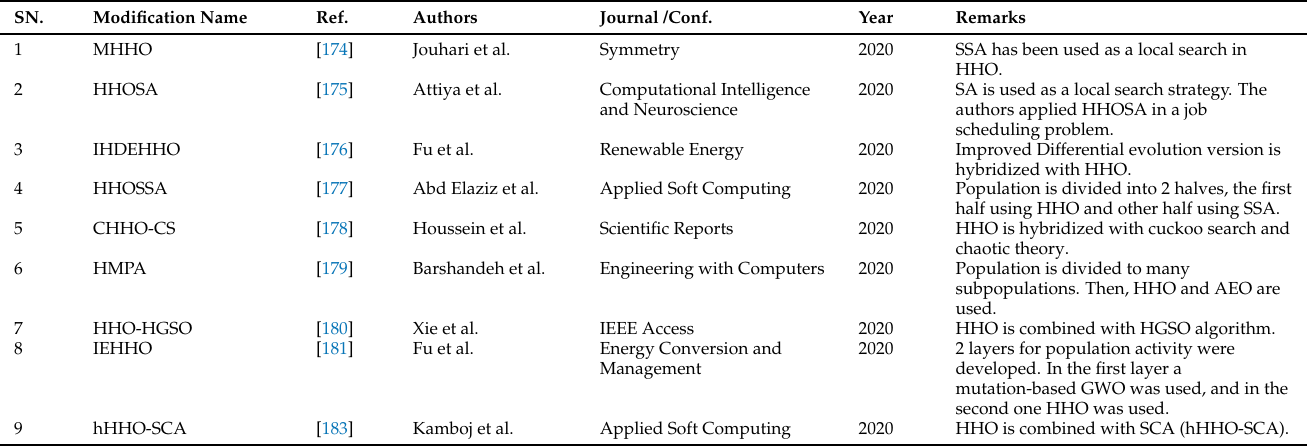
Table 8. Summary of the literature review on hybrid HHO